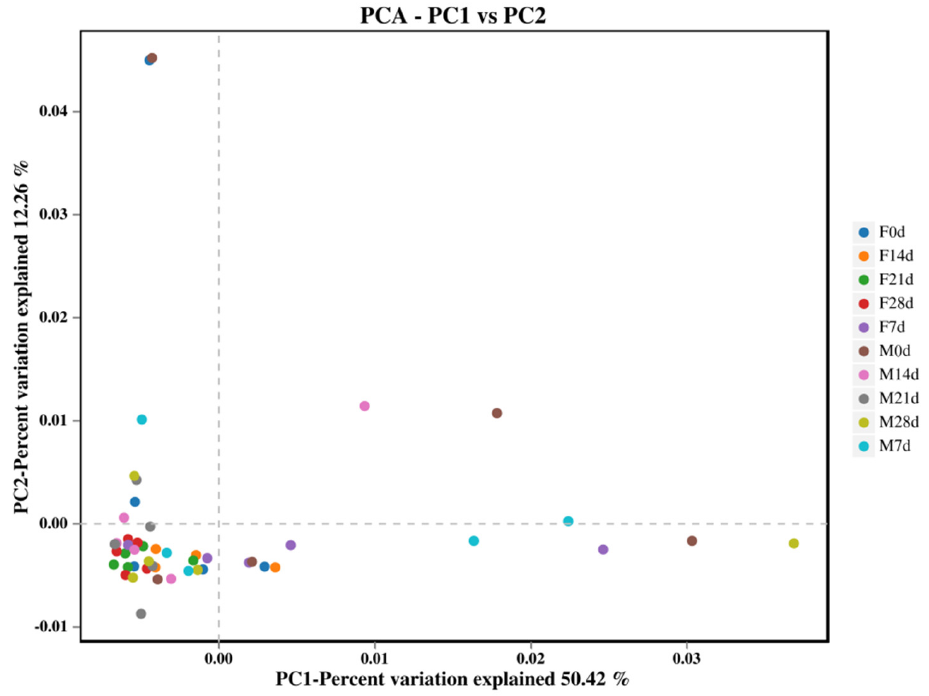
Figure 3. Similarity of fecal microbiota composition between weaned foxes reared on fish meal or a fly maggot protein replacement at different stages during the experimental period.